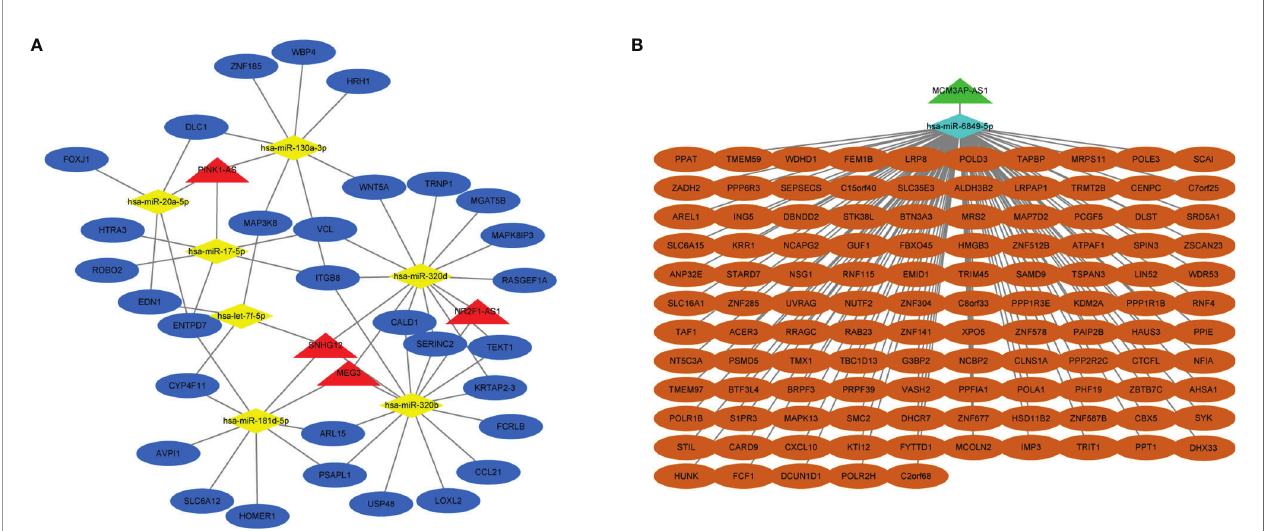
FIGURE 2 | Construction of lncRNA-mediated ceRNA regulatory network. (A) The upregulated lncRNA-mediated ceRNA regulatory network. (B) The downregulated lncRNA-mediated ceRNA regulatory network. Red means upregulated lncRNAs, yellow means downregulated microRNAs and mRNAs, blue means upregulated lncRNAs and microRNAs, and green means downregulated lncRNAs.